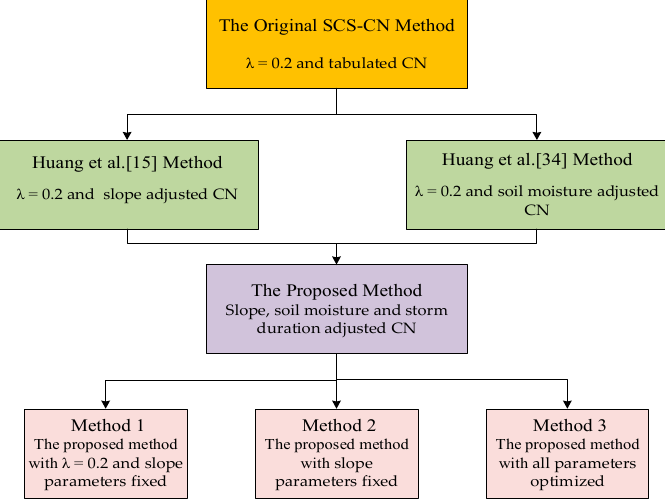
Figure 1. The flowchart of the whole methodology applied in this study.